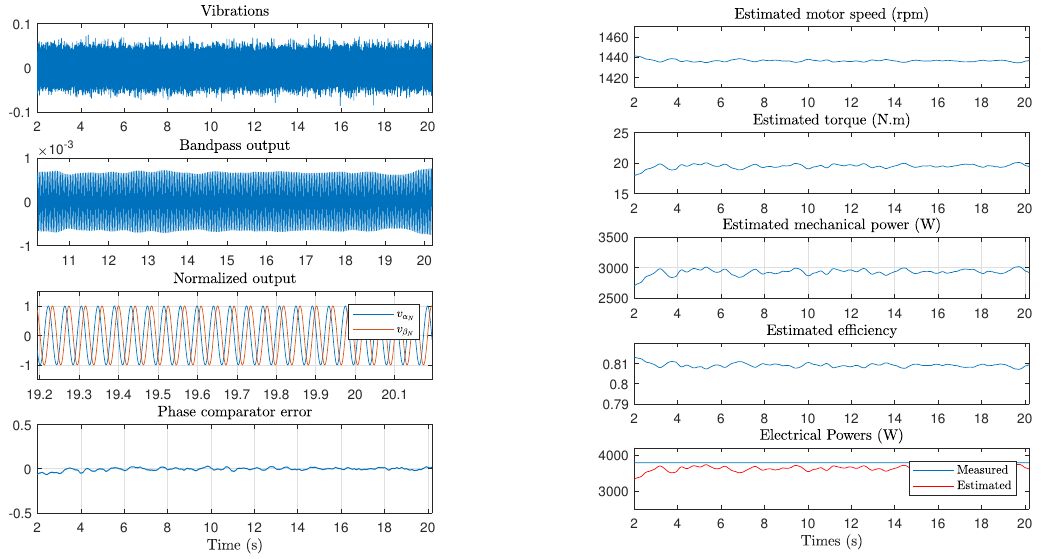
Figure 10. Experimental test at constant speed and full load operating